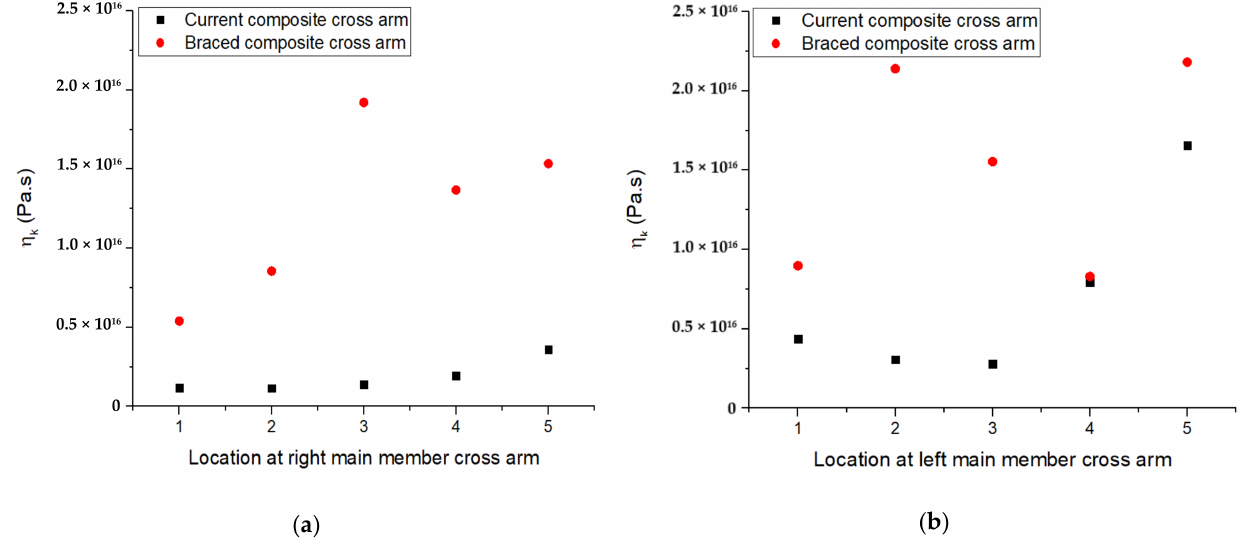
Figure 11. η k parameter for current and braced PGFRPC cross-arms: ( a ) right; ( b ) left main